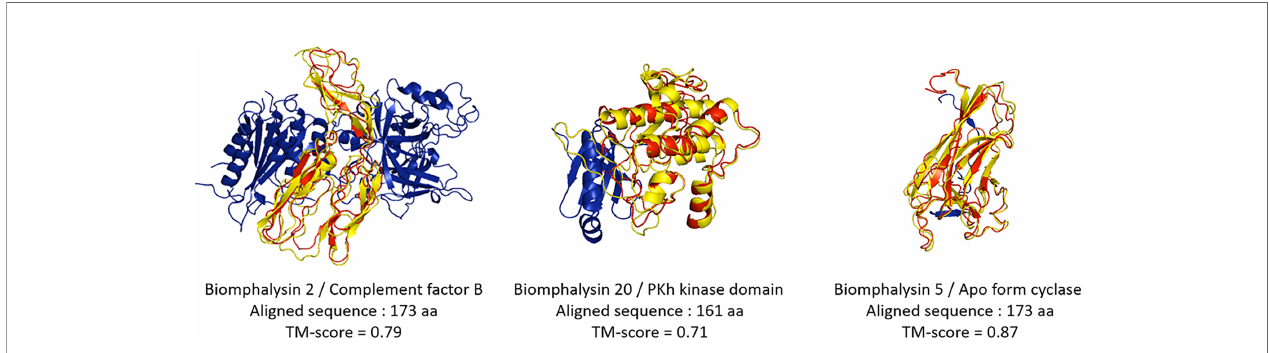
FIGURE 6 | Structural prediction of the biomphalysin small lobes. Three-dimensional structure prediction of small lobe of biomphalysin proteins 2, 5 and 20 was performed using I-Tasser server. A C-score was determined for each prediction (see Table S7 ). The small lobe of biomphalysin proteins 2, 5 and 20 were investigated against RCSB Protein Data Bank (PDB). A TM-score was calculated between the small lobes and the best hit found by I-Tasser server. A score greater than 0.5 reveals signi fi cant alignment. 3D superposition of each small lobe of biomphalysin 2, 5 and 20 and the respective best hit were performed by TM align and visualized with PyMOL. The best structural alignment was reported between the predicted isolated structure of the small lobe in red and the signi fi cant template hit identi fi ed